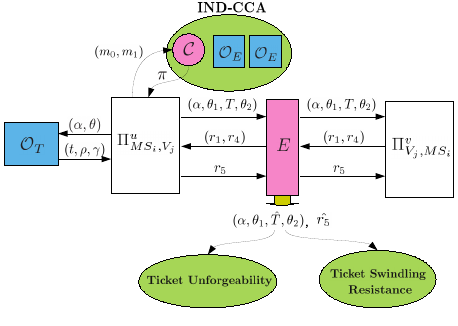
Figure 12. The proof model of Case 1.